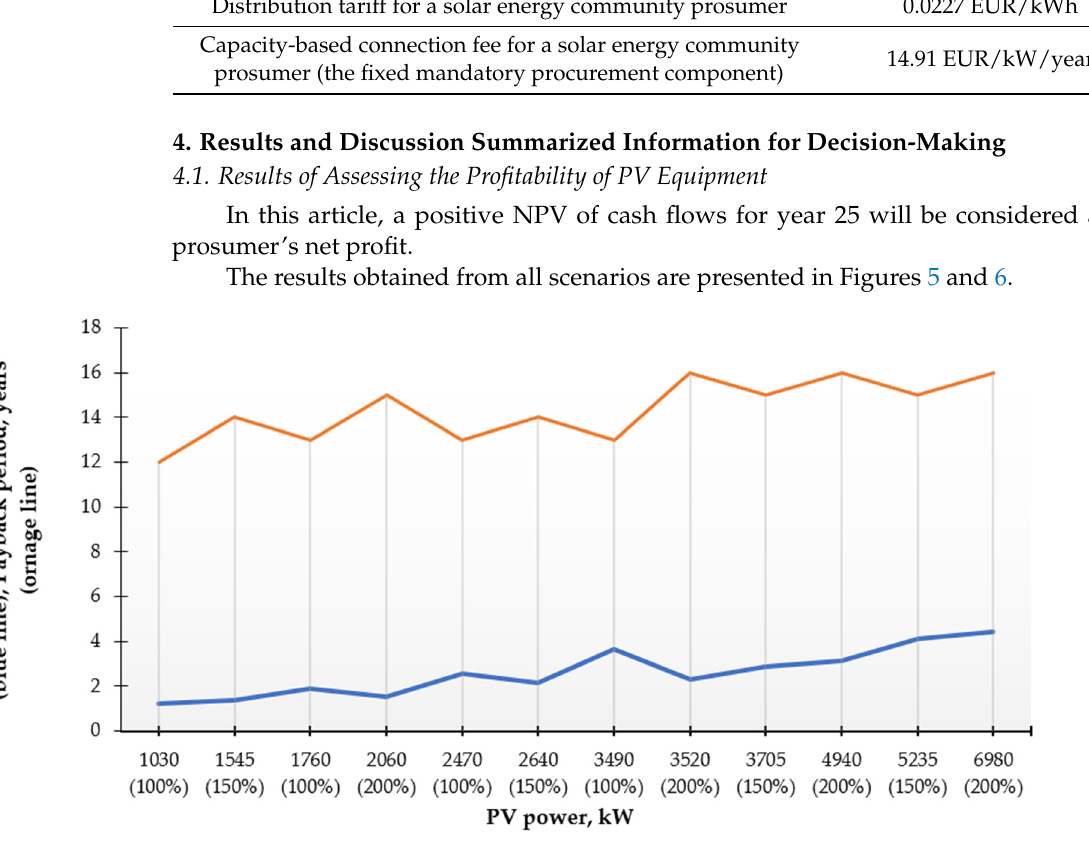
Figure 5. Net profit of prosumers and payback period results of analyzed scenarios for DP depending on PV installed power.